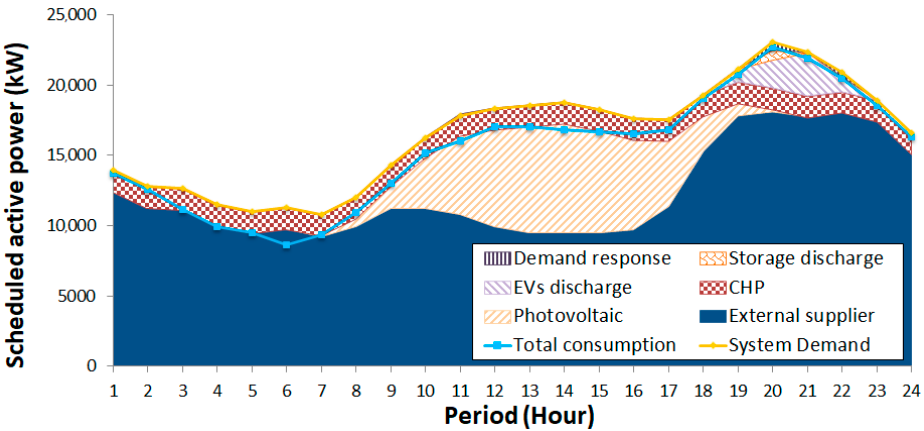
Figure 7. Energy resource scheduling of min(Cost).